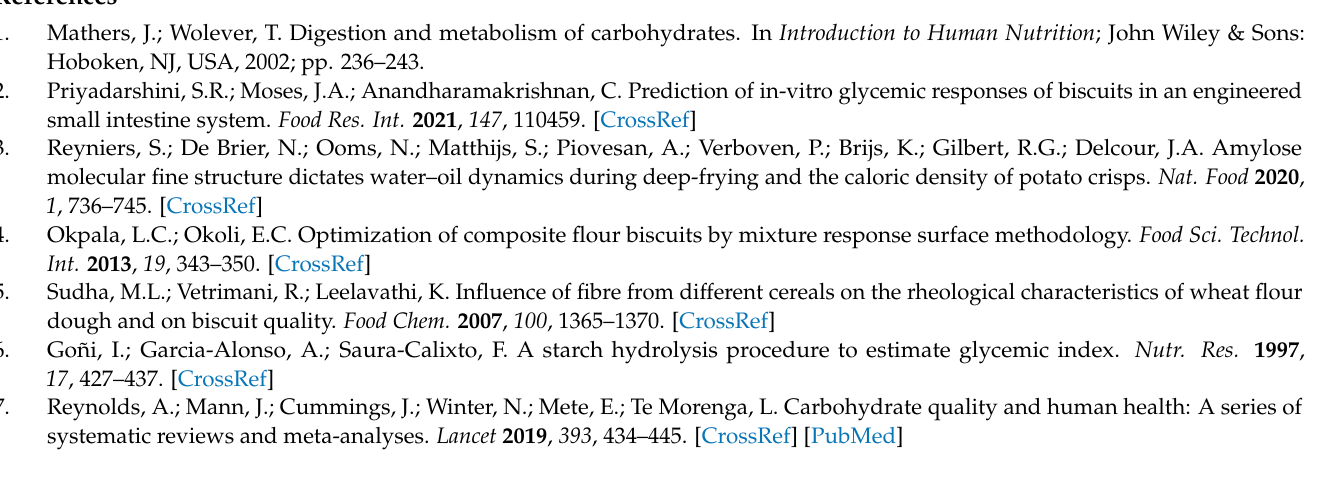
Table S1: Chemical compositions, and the GI and GL values of biscuits